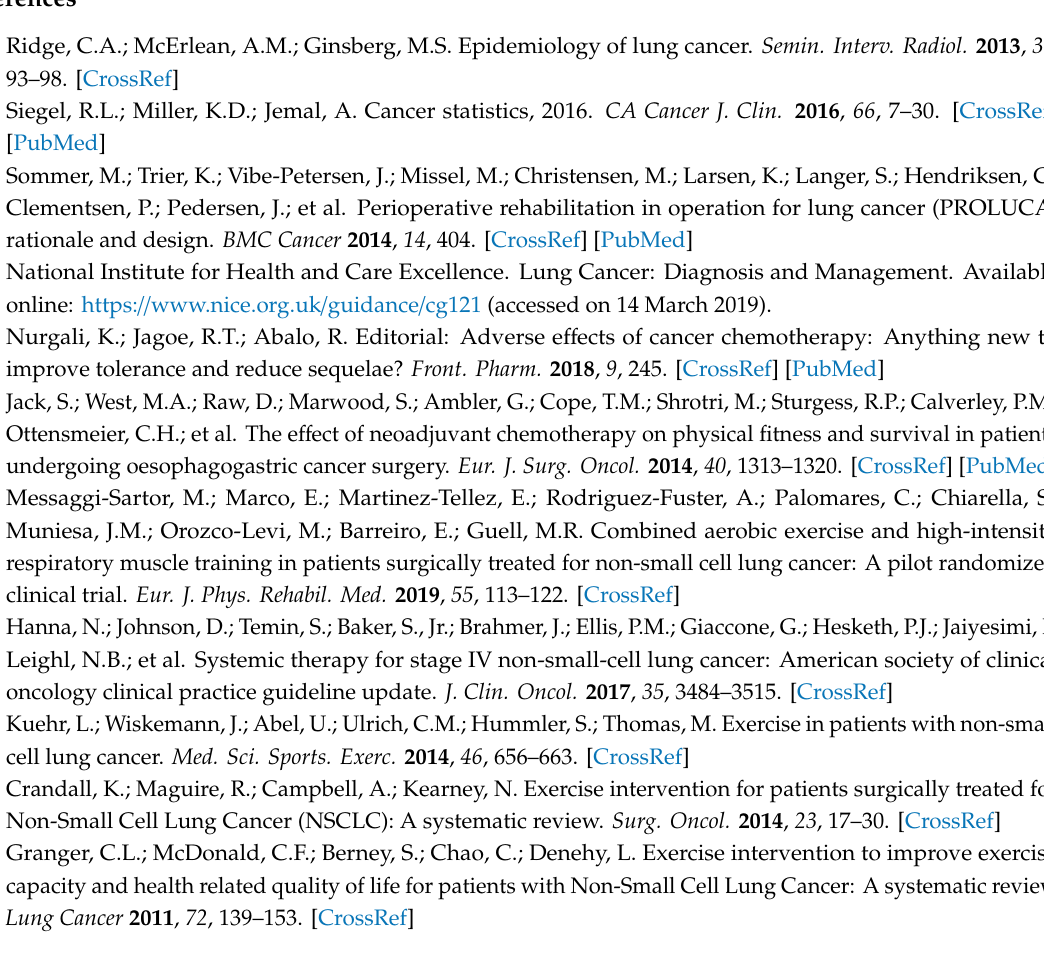
Figure S1: Pooled changes in secondary outcomes: DLCO (Di ff usion capacity of the lung for carbon monoxide); FVC (Forced vital capacity); FEV 1 (Forced expiratory volume in one second); Fatigue and PEF (Peak expiratory flow). Figure S2: Pooled changes in secondary outcomes: Emotional function; Physical function; and Health-related quality of life. Table S1: Search Strategy, Table S2: Exclusion criteria and the list of excluded articles. Author Contributions: I.D.R., R.R.-V., N.M.-V., and M.I. conceptualized and designed the study. N.M.-V. and